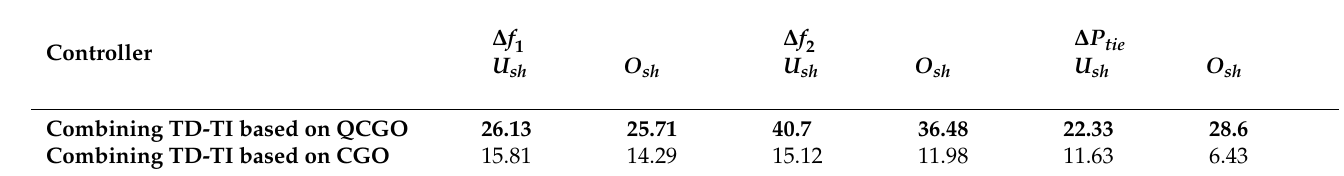
Table 15. Percentage improvement in U sh and O sh values for combining TD-TI/QCGO and combin- ing TD-TI/CGO based on combining TD-TI/SSA for scenario A.2.